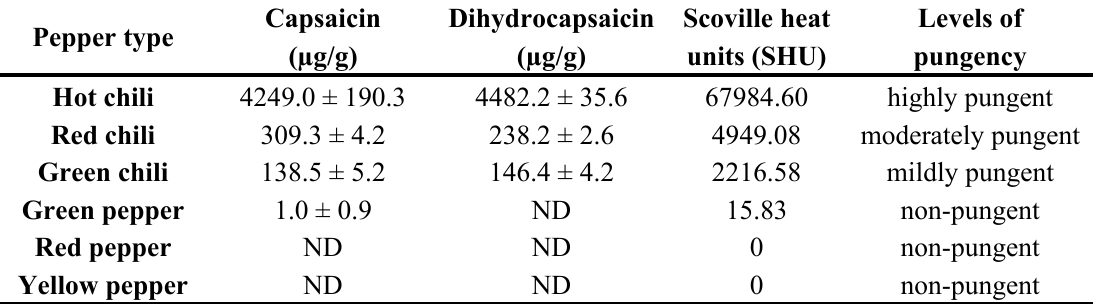
Table 2. Concentrations of capsaicin, dihydrocapsaicin and Scoville heat units (SHU) in the analyzed pepper